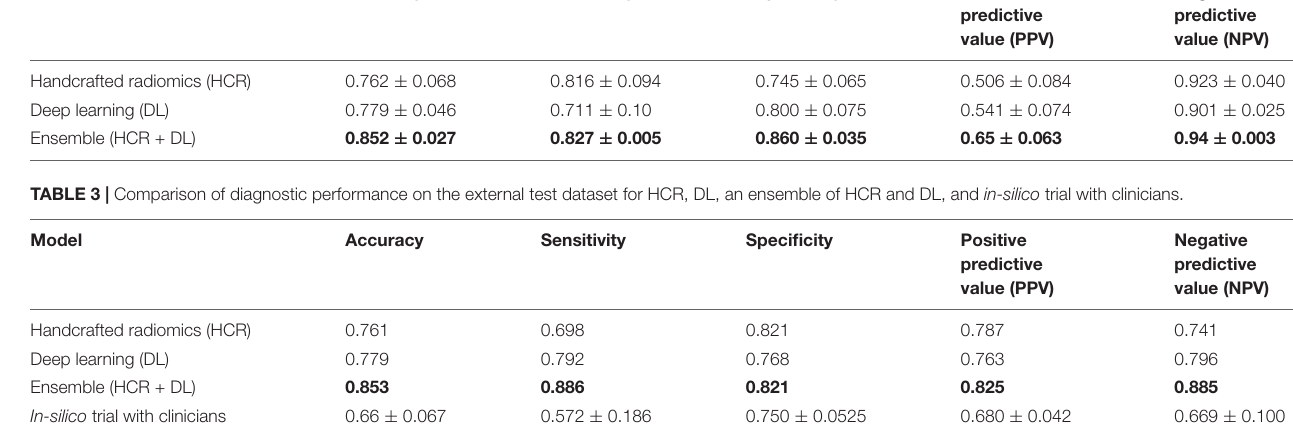
Negative predictive predictive value (PPV) value (NPV)